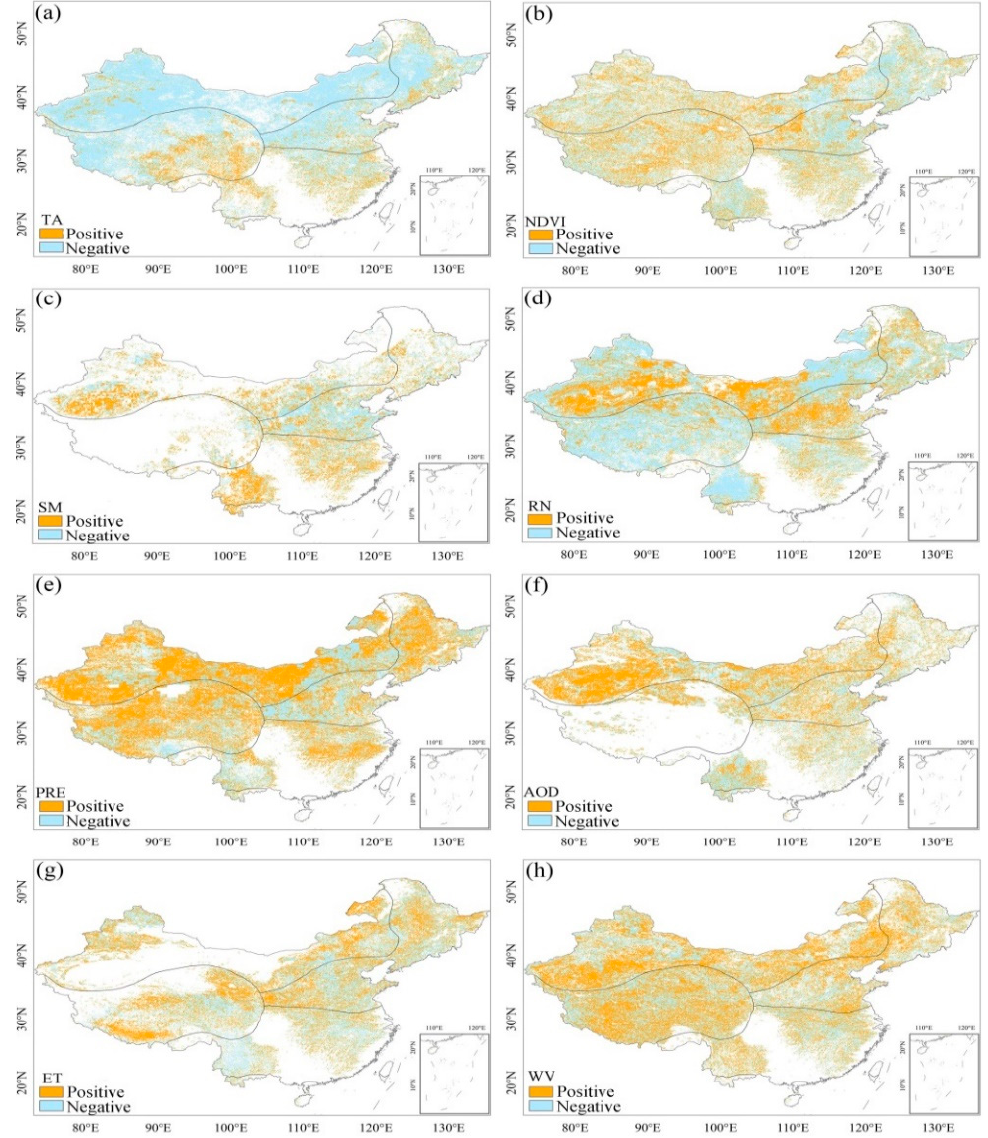
Figure 11. Spatial distribution of ECCM test results between LST and each environmental factor. ( a ) TA ( b ) NDVI ( c ) SM ( d ) RN ( e ) PRE ( f ) AOD ( g ) ET ( h ) WV. The yellow area indicates pixels with positive time lag and the blue area indicates pixels with negative time lag. After pseudo-causal elimination with SST, multivariate EDM, and ECCM, the pro- portion of each environmental factor as a driver of the LST was determined. As shown in Figure 12, the highest percentage of driving factors among the environmental factors at the national scale was TA, accounting for 50.11%. ρ ccm had a mean value of 0.96. From different climate zones, the mean value of ρ ccm between TA and LST, as well as the percentage as a driving factor, showed a gradual decrease from north to south, indicating that LST was influenced by TA in its scope and intensity, both of which gradually weakened from